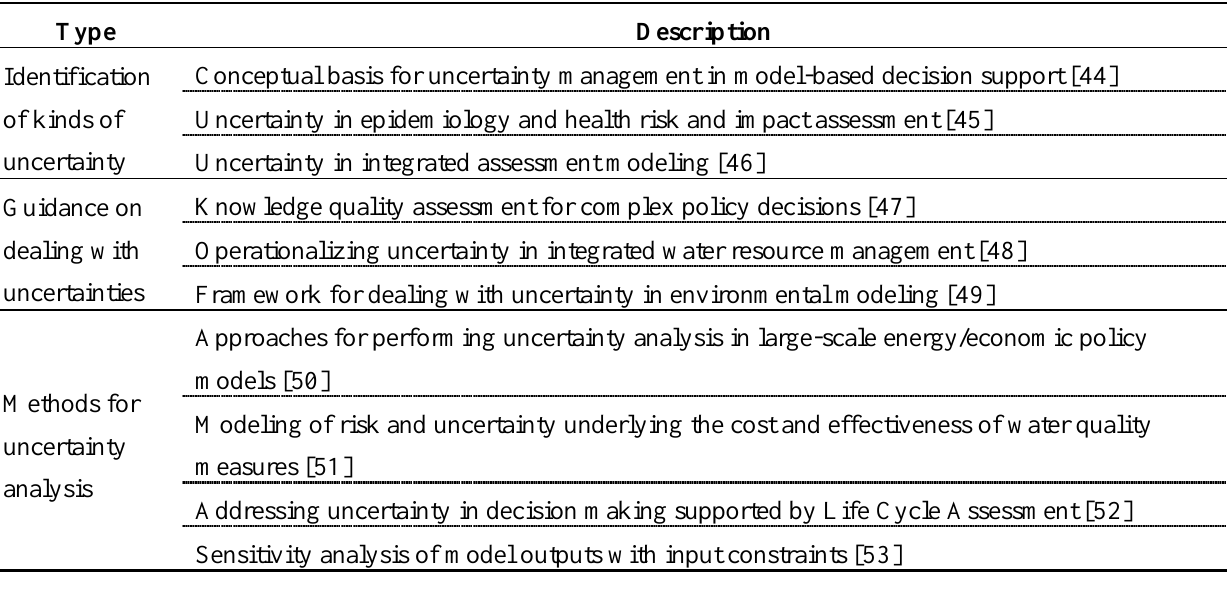
Table 2. Examples of uncertainty analysis perspective to assessment and model performance.